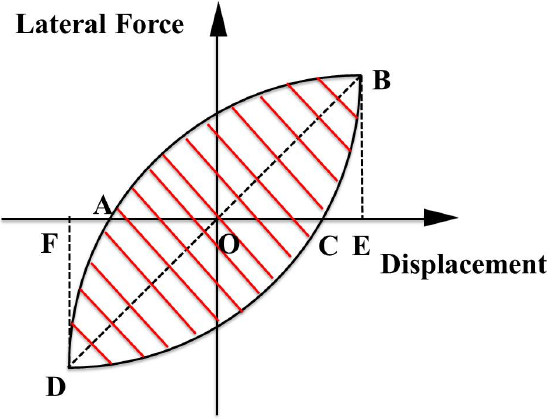
Figure 12. Schematic of the load–deformation hysteresis curve.